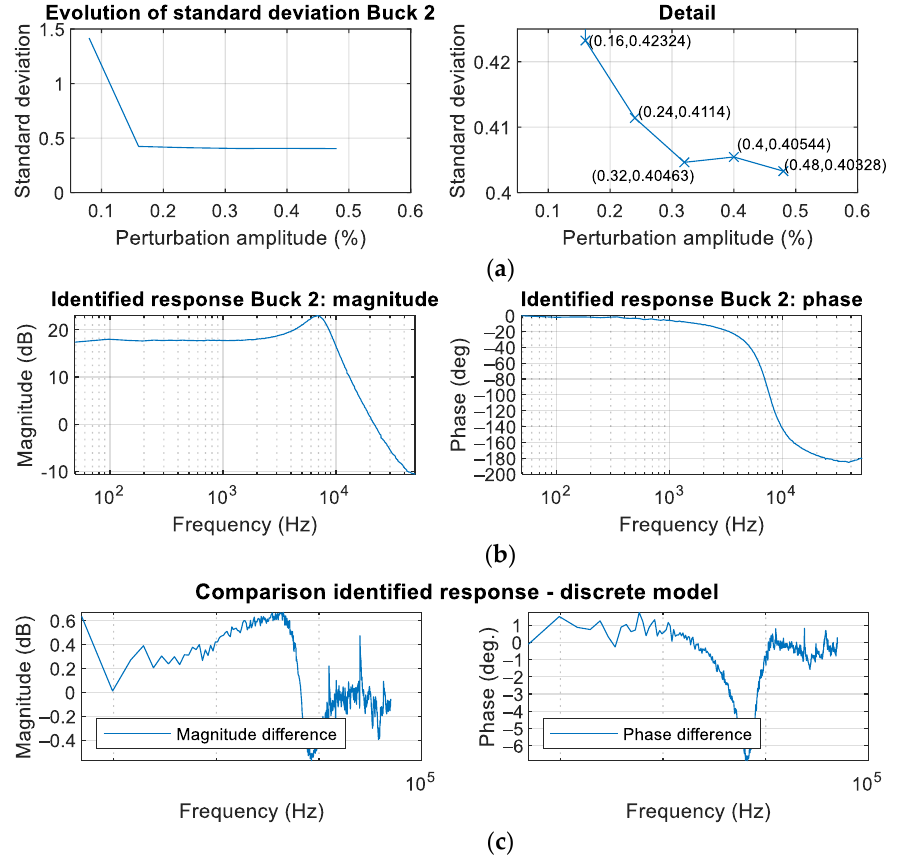
Figure 10. Determination of the perturbation amplitude for converter Buck 2 (Table 1). ( a ) Evolution of the standard deviation. ( b ) Identified frequency response. ( c ) Difference between the identified frequency response and discrete theoretical model.